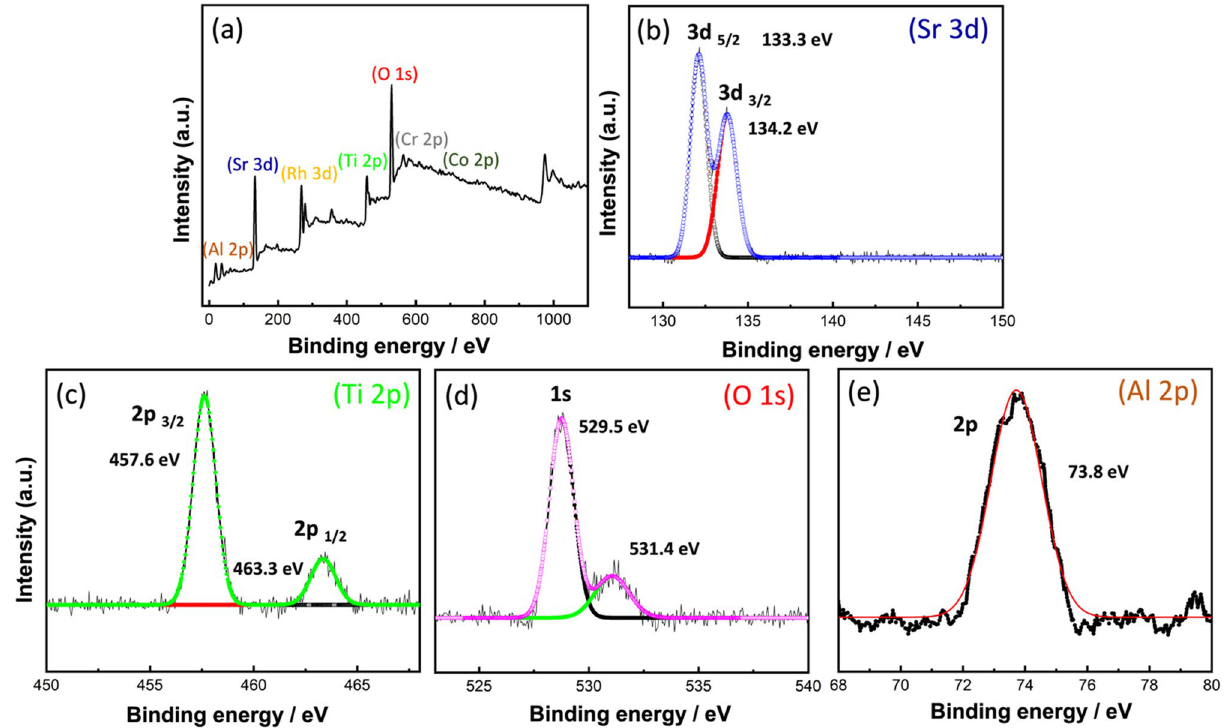
Figure 4. XPS analysis of the prepared cocatalyst loaded Al-SrTiO 3 sample, ( a ) survey analysis, deconvoluted ( b ) Sr, ( c ) Ti, ( d ) O, and ‘( e )